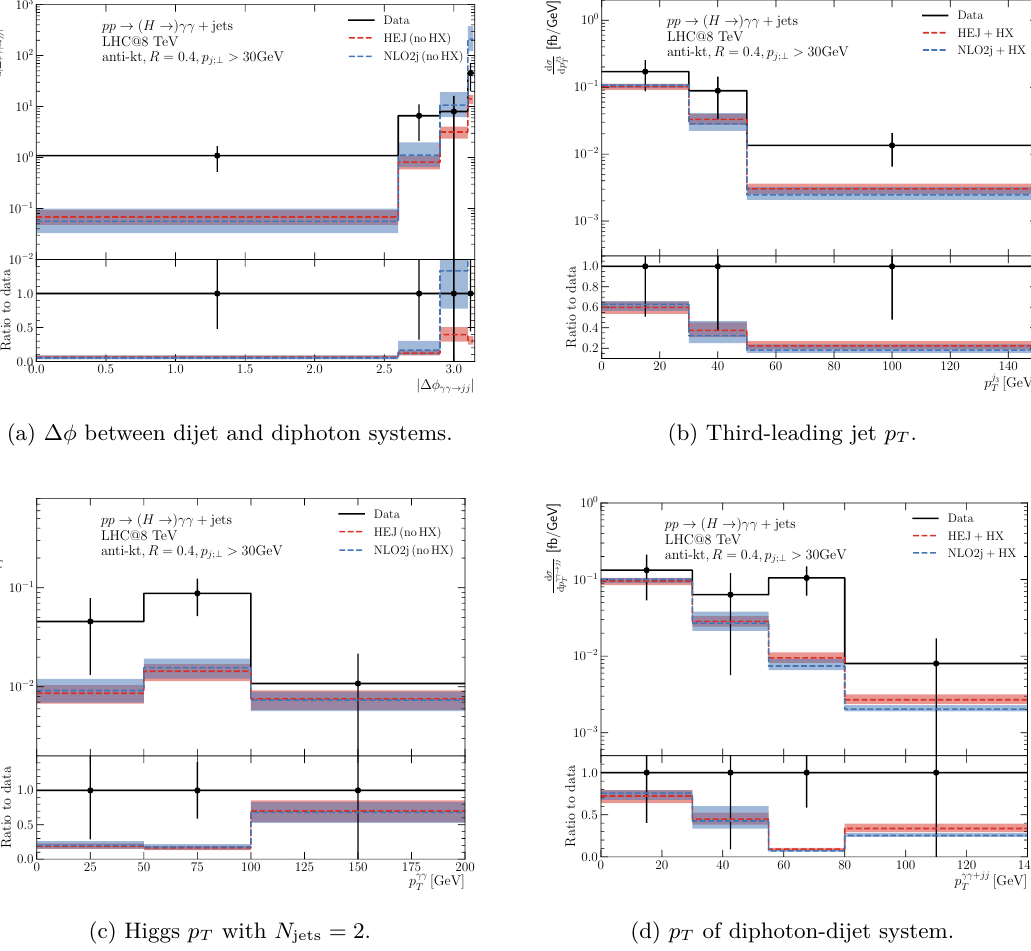
Figure 11. (a): azimuthal angle difference between dijet and diphoton objects. (b): transverse momentum of the third-leading jet. (c): transverse momentum of the Higgs boson in the ≥ 2-jet bin. (d): transverse momentum of the Higgs plus dijet object: ( p H + p j HEJ predictions are rescaled by the inclusive cross section ratio σ NLO2J /σ HEJ 2J . In (b) and (d), the “HX” component is extracted from [33]; this was not available for (a) and (c). If more inclusive cross-sections are considered, say from the rapidity of the second hardest jet histogram over all the experimental range, then the 2-jet reweighting factor would be further away from the 1-jet value (1.79 for the central scale instead of